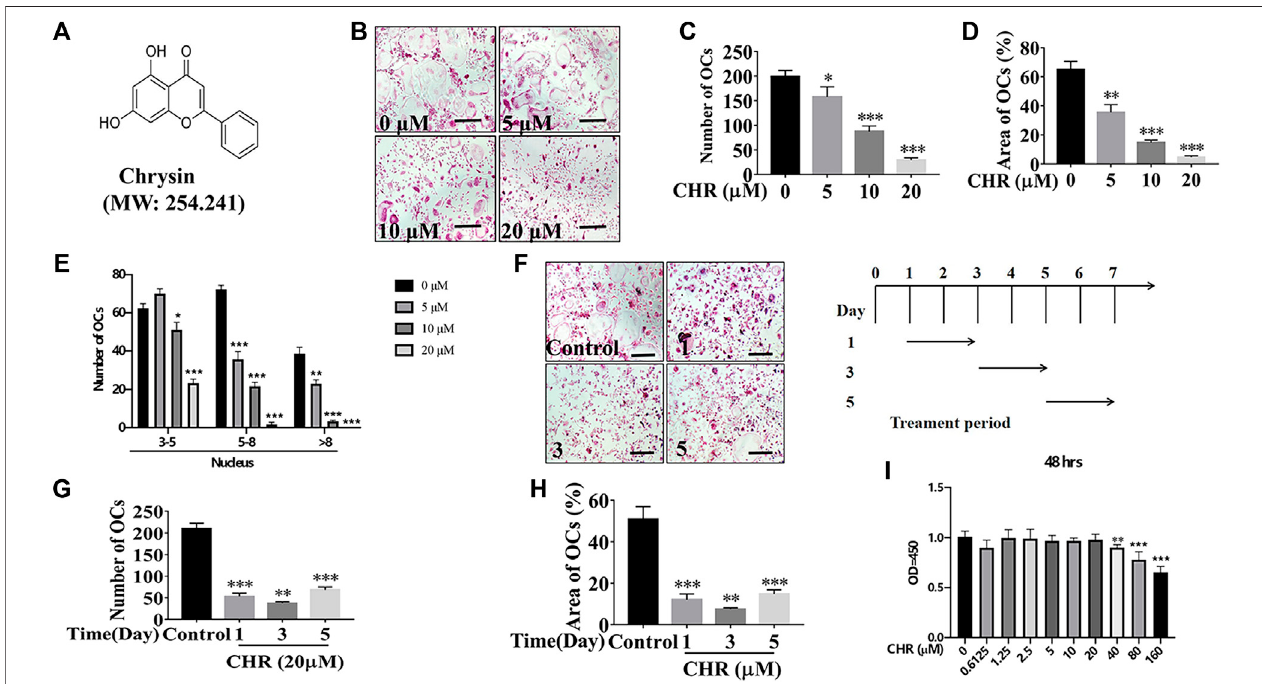
FIGURE 1 | CHR reduced RANKL-induced OC formation. (A) Chemical structure of CHR. (B) Murine BMMs were dose-dependently treated with indicated concentrations of CHR, 30 ng/ml M-CSF, and 100 ng/ml RANKL for 6 days and then stained for TRAcP activity (Magni fi cation = ×100; scale bar = 100 µM). (C) The numbersofTRAcPpositivemultinucleatedOC(nuclei > 3)werequanti fi ed(n=3). (D) ThepercentageofOCareafrompanelBwasmeasured. (E) Quantitativeanalysisof osteoclast number with different nuclear numbers. (F) Murine BMMs were stimulated with 30 ng/ml M-CSF and 100 ng/ml RANKL in the presence of 20 μ M CHR for 1, 3, or 5 days. Cells were then fi xed and stained for TRAcP activity (Magni fi cation = ×100; scale bar = 100 µM). (G) The numbers of TRAcP positive multinucleated OC (nuclei > 3) were quanti fi ed (n = 3). (H) The percentage of OC area from panel F was measured. (I) BMMs were treated with indicated concentrations of CHR and 30 ng/mlM-CSF,for48 h;Cellviabilitywasmeasured using CCK-8 assayinaccordancewithmanufacturer ’ sprotocol.(n=5)(* p < 0.05,** p < 0.01, *** p < 0.001versus the 0 or positive control).